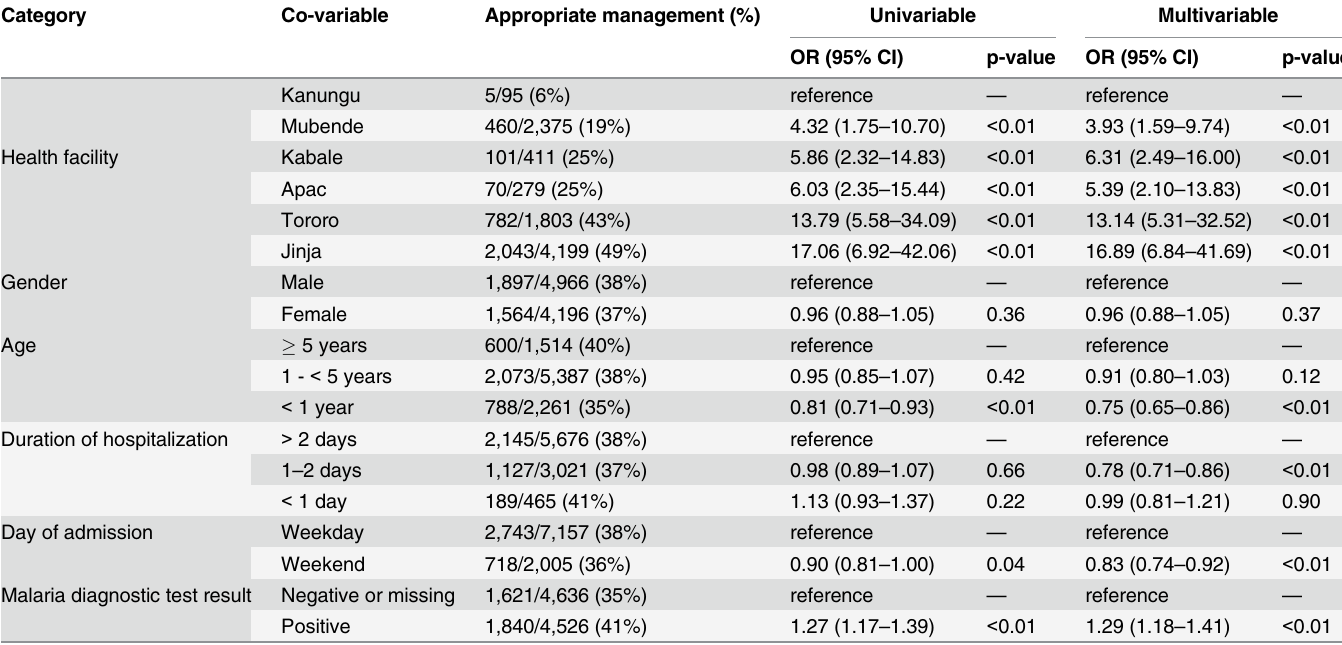
Table 6. Associations between characteristics and receipt of appropriate inpatient case management for suspected anemia.